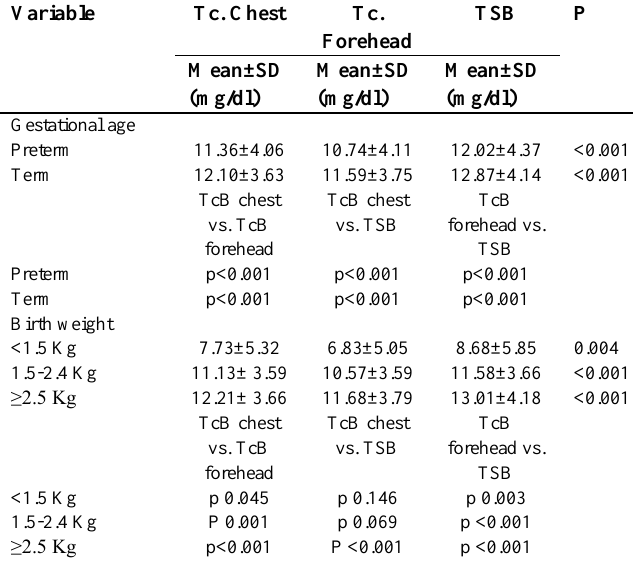
Table (8): Distribution of bilirubin level according to technique for gestational age and birth weight